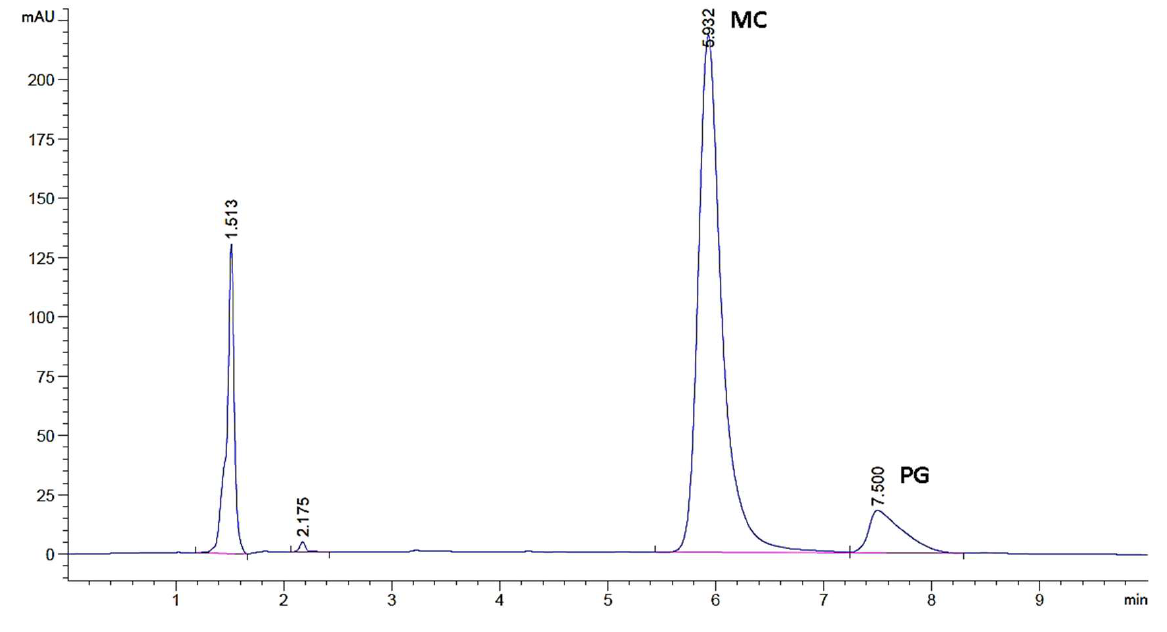
Figure 2. Chromatogram of PG and MC.